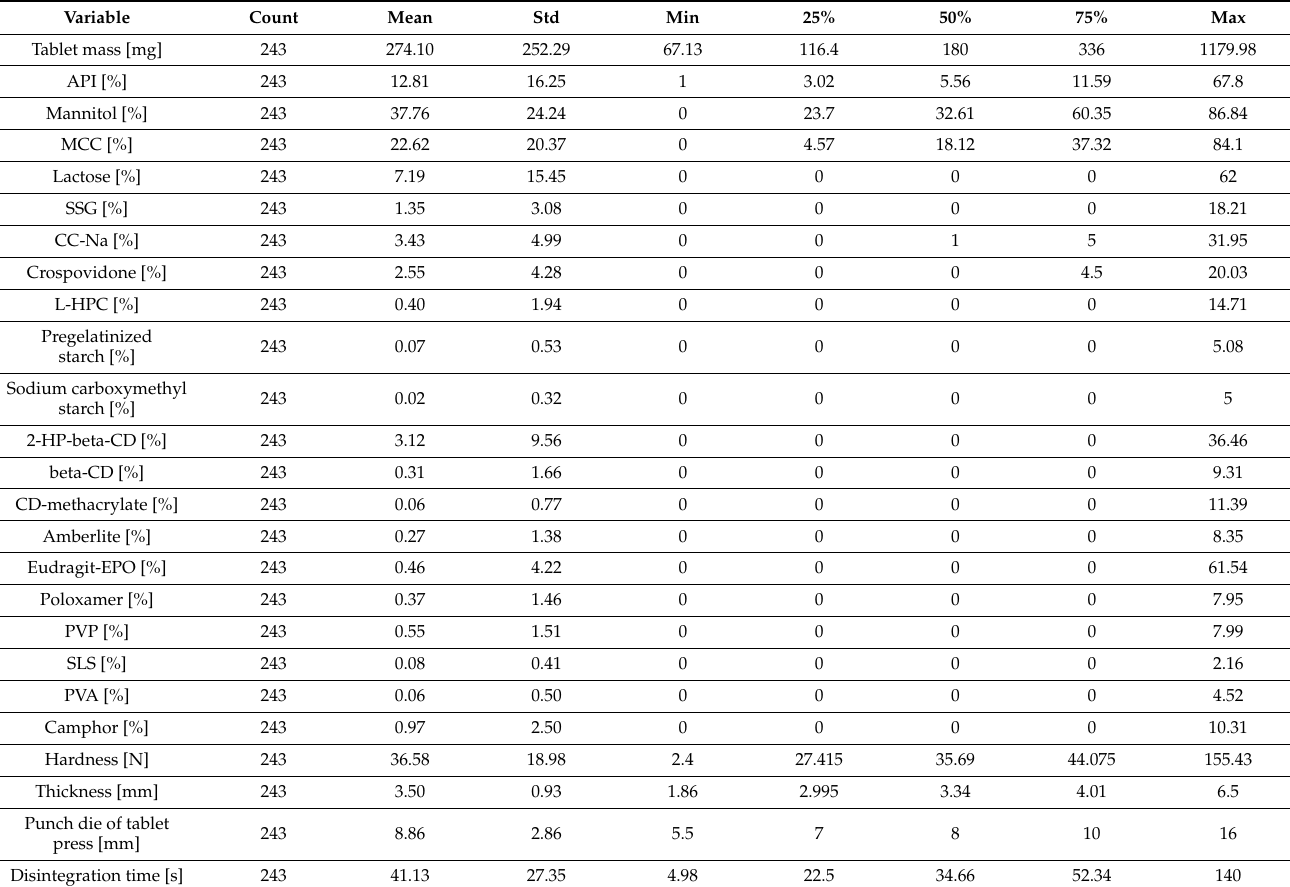
Table 2. Descriptive statistics of the database. MCC, microcrystalline cellulose; CC-Na, croscarmellose sodium; SSG, sodium starch glycollate; L-HPC, low-substituted hydroxypropyl-cellulose; PVP, polyvinylpyrrolidone; PVA, polyvinyl alcohol; SLS, sodium lauryl sulfate; MgSt, magnesium stearate; SSF, sodium stearyl fumarate; API, active pharmaceutical ingredient; 2-HP-beta-CD, 2-hydroxypropyl- beta-cyclodextrin; CD-methacrylate,